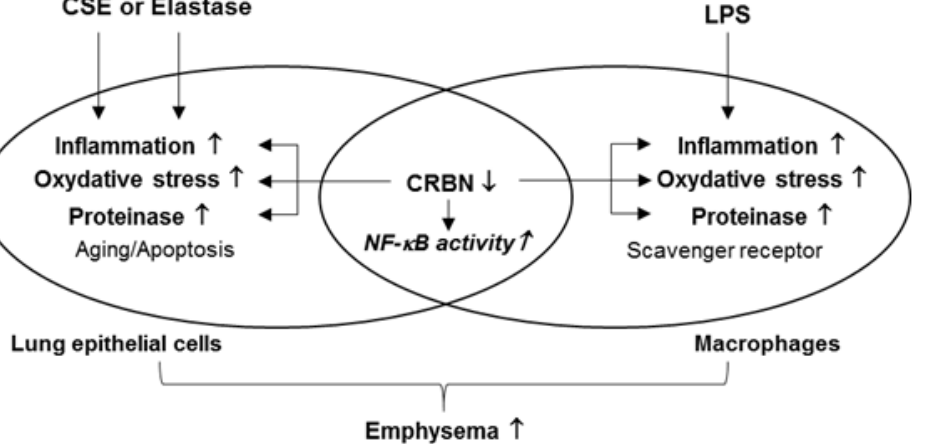
Figure 8. Proposed mechanism for the role of CRBN on the development of emphysema. Crbn deficiency enhances elastase-, CSE-, or LPS-induced inflammation, oxidative damage, and MMP9 expression in lung epithelial cells and macrophages. However, cellular aging and apoptosis in lung epithelial cells and the surface expression levels of scavenger receptors such as MARCO and SR-A in macrophages were not affected by CRBN expression. Increased inflammation, oxidative damage, and MMP9 expression induced by Crbn deficiency might augment the development of emphysema.